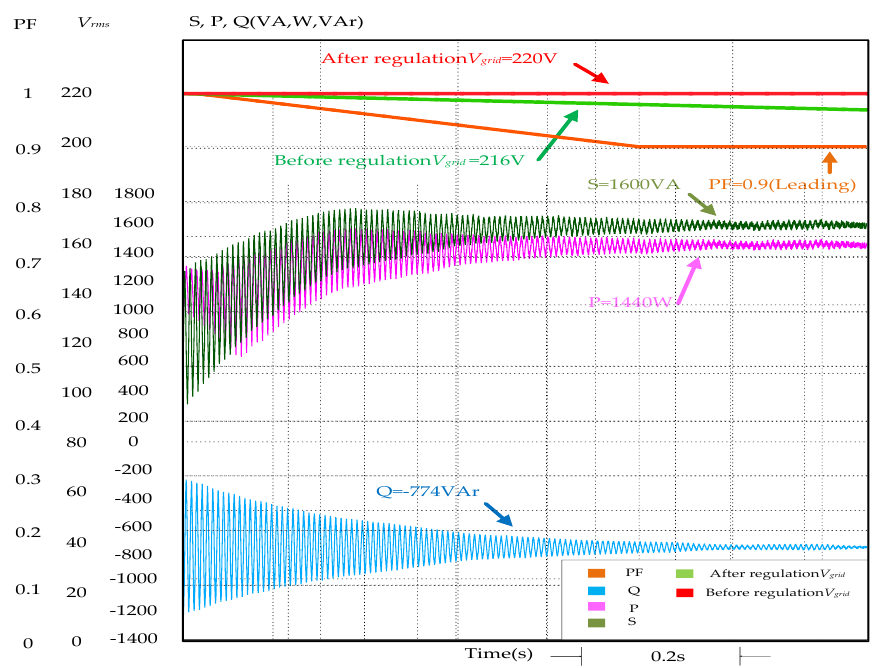
Figure 15. The mains voltage V grid before and after regulation, the output PF regulation, real power, reactive power, and apparent power of the smart inverter when the per-unit value of mains voltage was between 0.97p.u. and 1p.u.